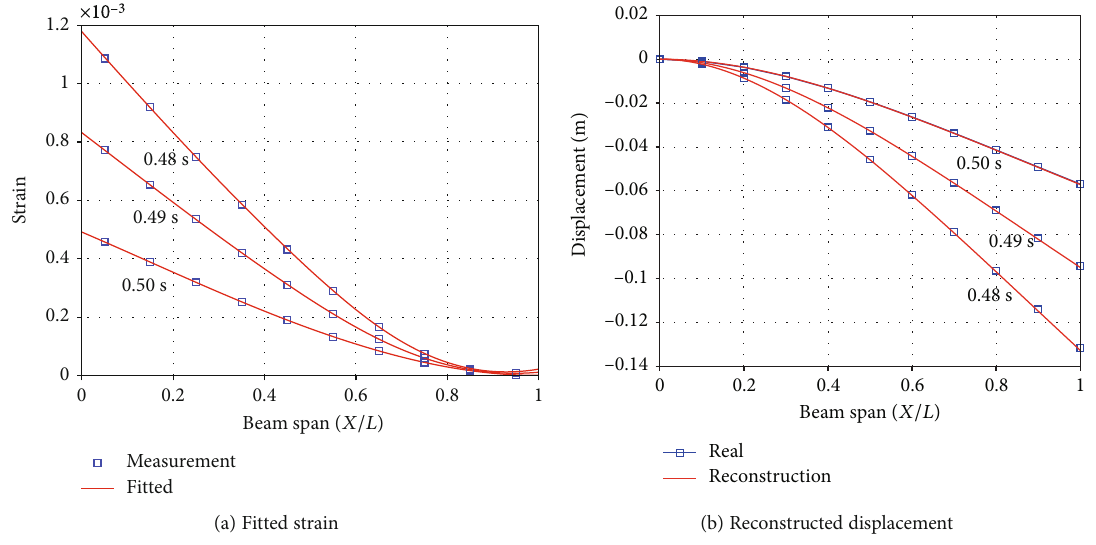
Figure 9: Fitted strain and reconstructed displacement at 0.5, 0.49, and